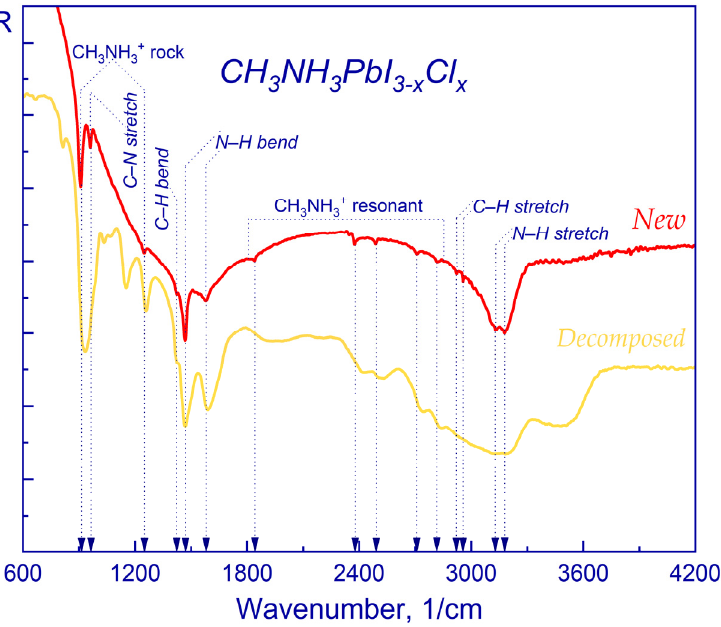
Figure 2. IR spectra of CH 3 NH 3 PbI 3-x Cl x : freshly prepared (red) and exposed to illumination (yellow).